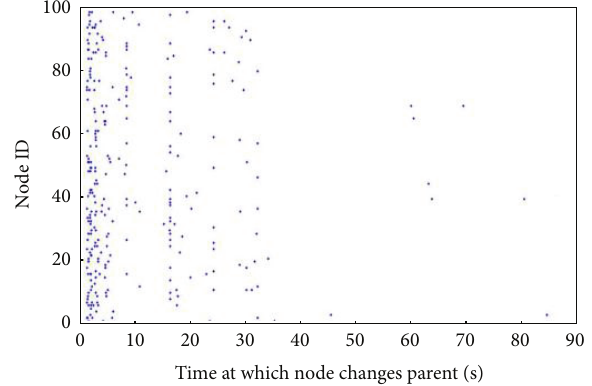
Figure 6: Distribution of the parent changes.